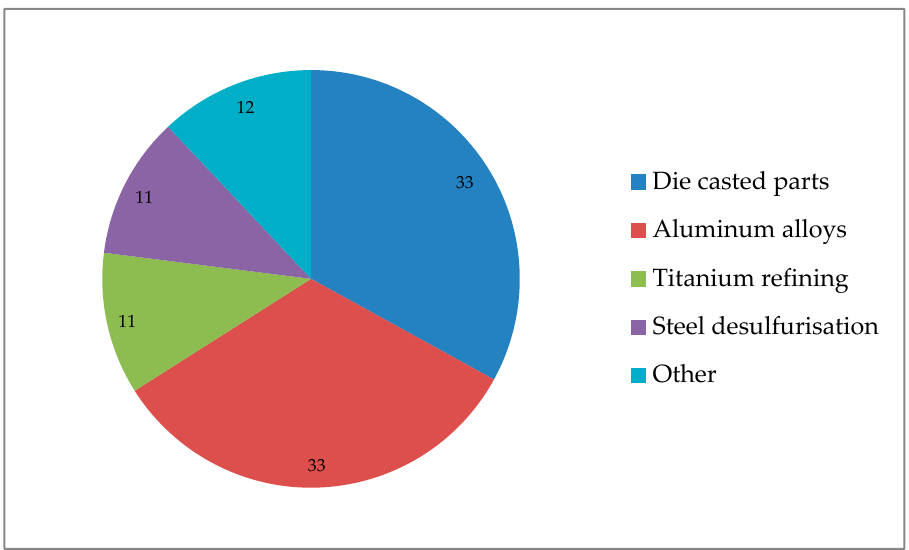
Figure 1. Global consumption of major Mg applications in 2012 (in %).